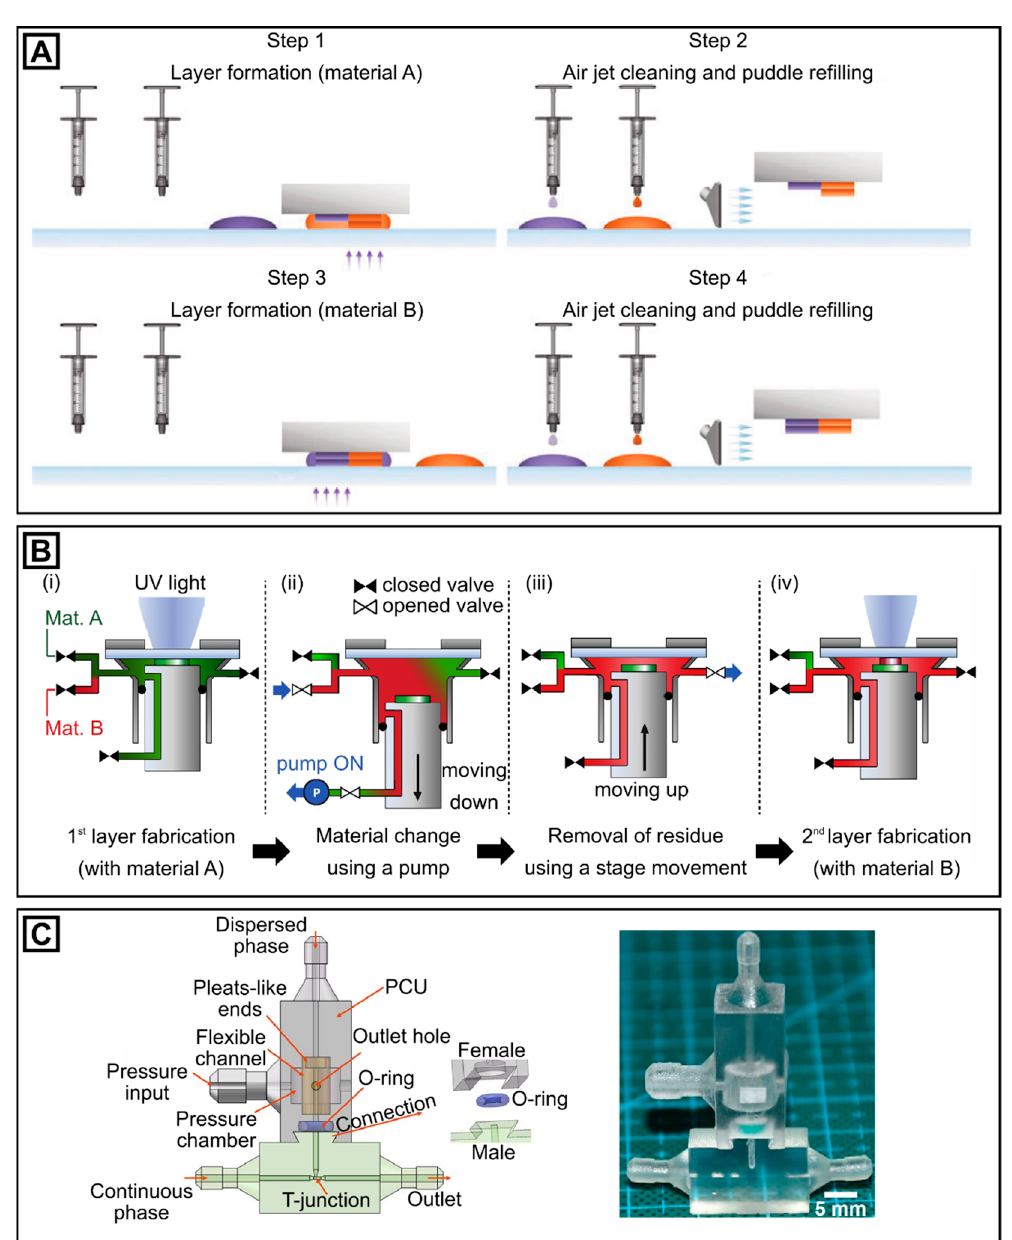
Figure 2. Multimaterial 3D printing based on PµSL. ( A ) Two different materials are processed together by a modified vat switching system. Syringes control the amount of resin placed on the glass. Pressurized air removes uncured resin to avoid introducing surface impurities when switching between resins. Adapted with permission from Ge et al. [79] ( B ) Resin exchange in multimaterial PµSL within a few seconds using dynamic fluid control of different resins within an integrated flow cell replacing the conventional resin vat. Adapted with permission from Han et al. [38] ( C ) Pre-fabricated microfluidic parts made from different materials assembled into a functional flow cell for emulsion formation. Adapted with permission from Ji et al.